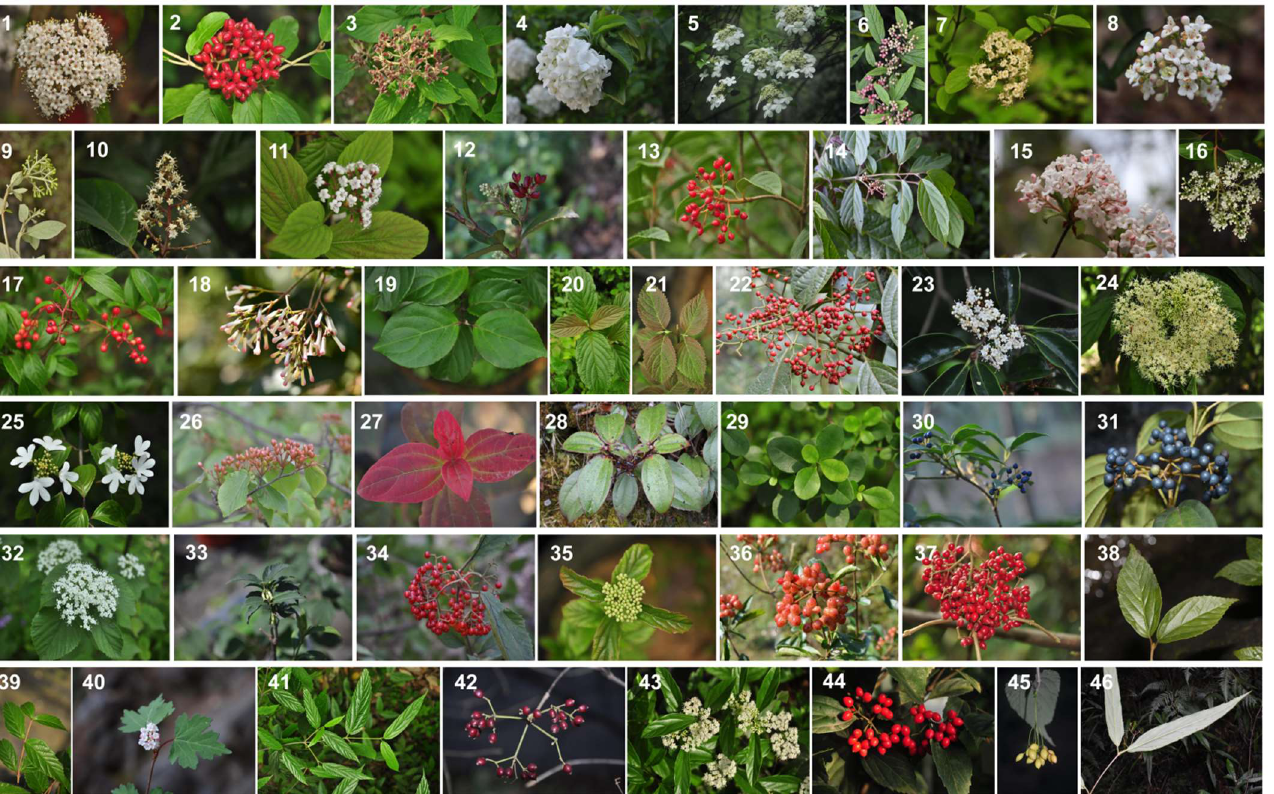
Figure 1. Some endemic taxa of the genus Viburnum in China. 1 V. buddleifolium , 2